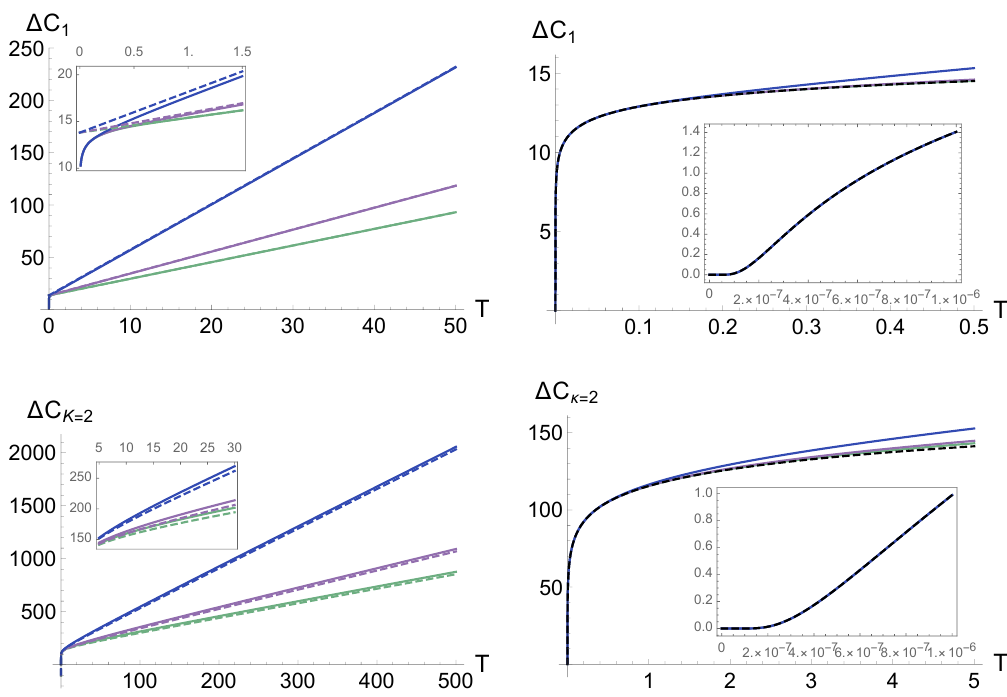
Figure 18 . Complexity of formation for different values of Ω as a function of the temperature T , with L = 1 , N = 20000 and m = 10 − 6 . From the bottom up Ω = 0 . 1 (green), Ω = 0 . 5 (violet) and Ω = 0 . 8 (blue). The left panels illustrate how for sufficiently large temperatures the complexity of formation agrees well with the analytic expression (4.38) and (4.39) (dashed lines). The right panels show that for sufficiently low temperatures the Ω -independent zero-mode contribution (4.33) (dashed black) dominates the sum over